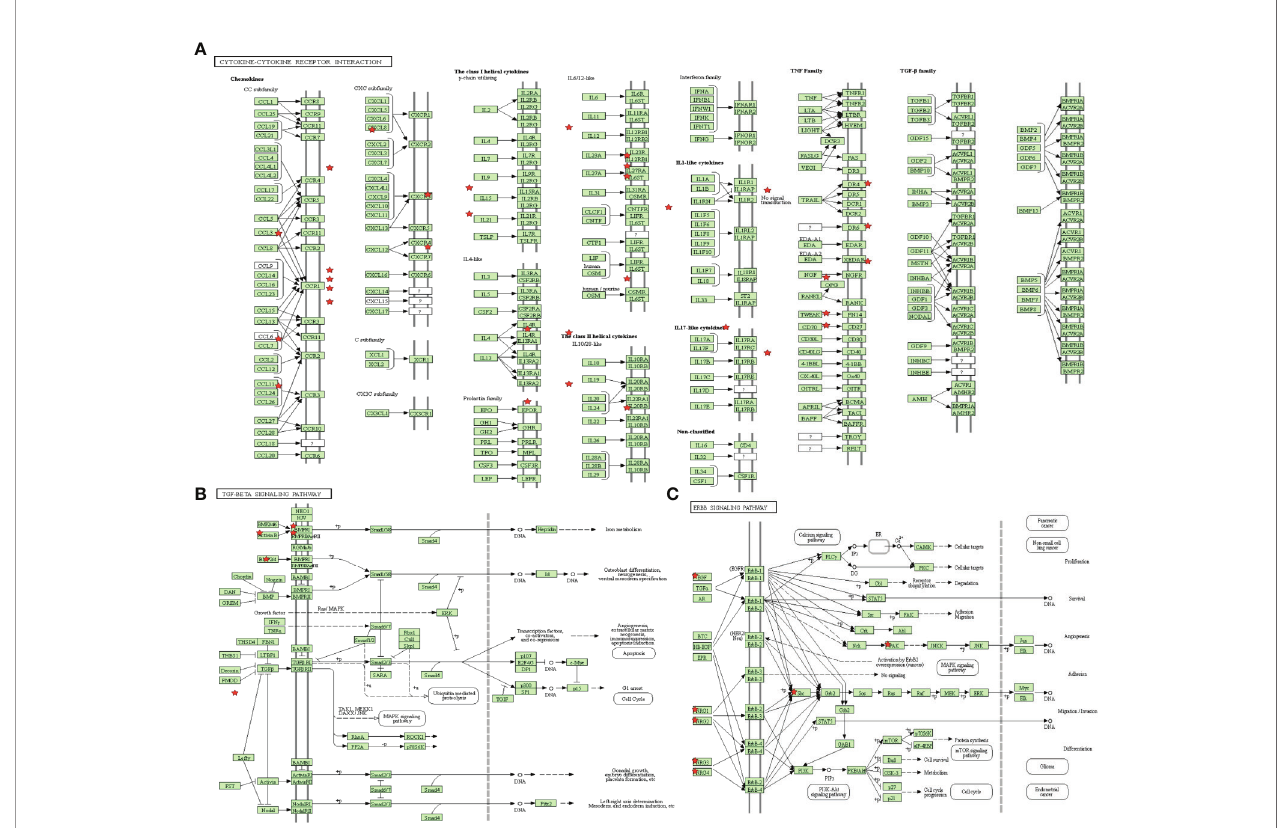
FIGURE 8 | The signi fi cant immune-related pathways of differentially expressed immune-related genes (DEIRGs) in stomach adenocarcinoma (STAD). (A) DEIRGs signi fi cantly enriched in cytokine-cytokine receptor interaction pathway. (B) DEIRGs signi fi cantly enriched in TGF- b signaling pathway. (C) DEIRGs signi fi cantly enriched in ErbB signaling